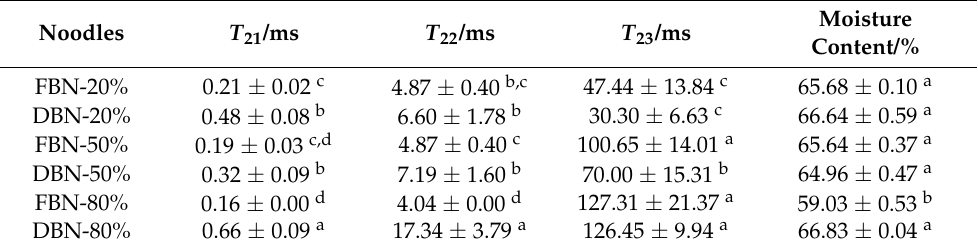
Table 4. Transverse relaxation time ( T 2 ) of water in different status/distribution for uncooked FBN and DBN and moisture content for cooked FBN and DBN.